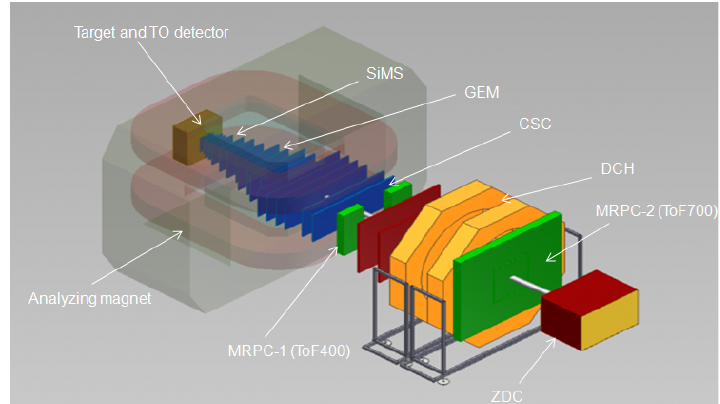
Figure 1. Schematic view of the BM@N experimental setup: SiMS – Silicon Micro-strip Sensors, GEM – Gas Electron Multipliers, CSC – Cathode Strip Chamber (CSC), mRPC – Multi-gap Resistive Plate Chambers, DCH – Drift Chambers, ZDC – Zero Degree